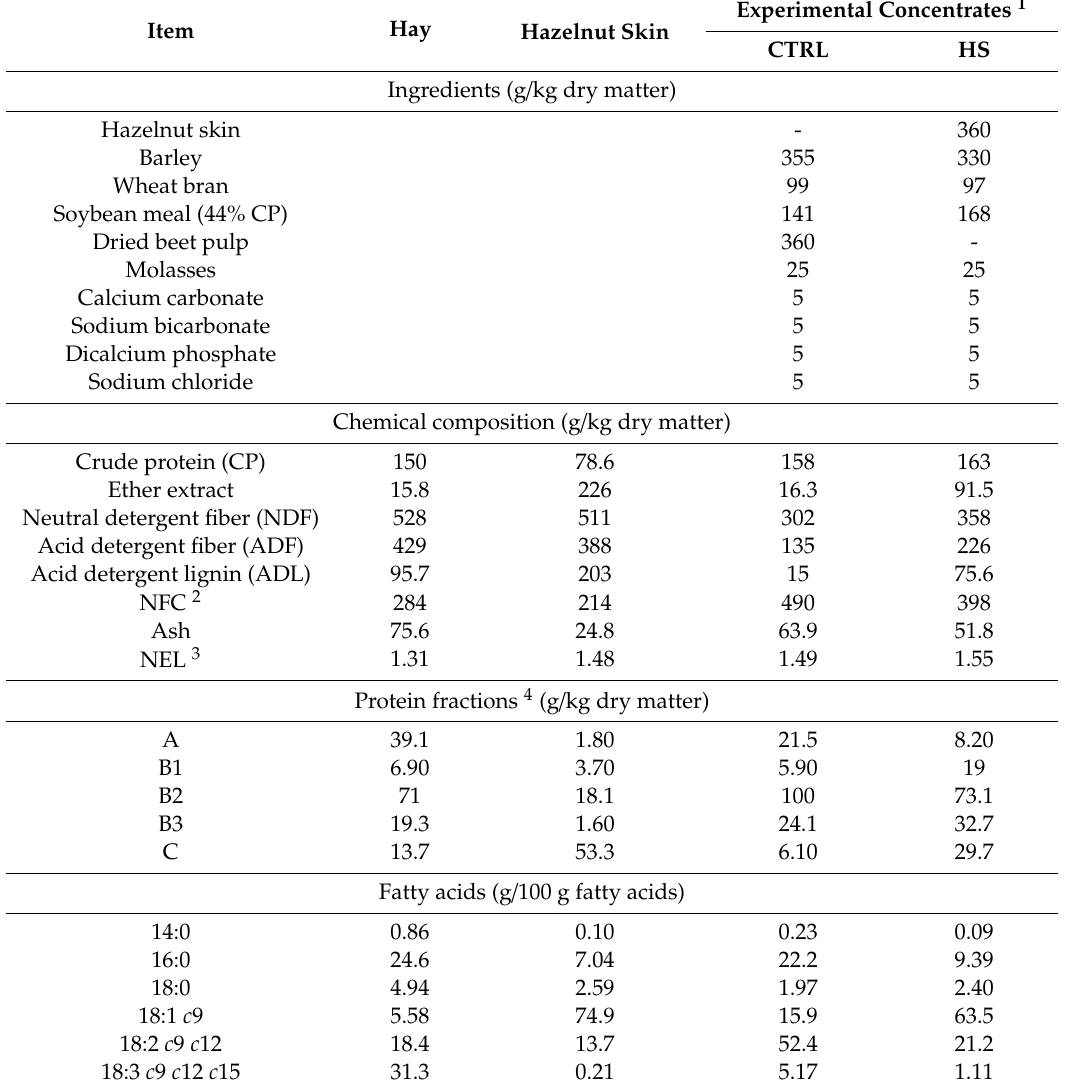
Table 1. Ingredients and chemical and fatty acid composition of the experimental treatments and of the hay and hazelnut skin administered to the ewes. Item